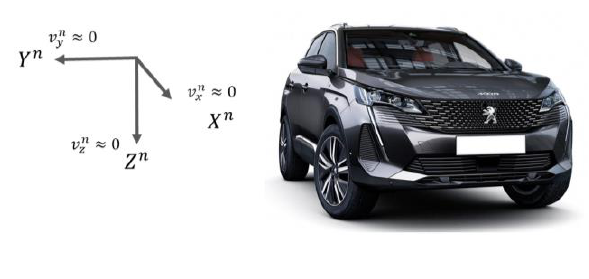
Figure 4. Schematic of